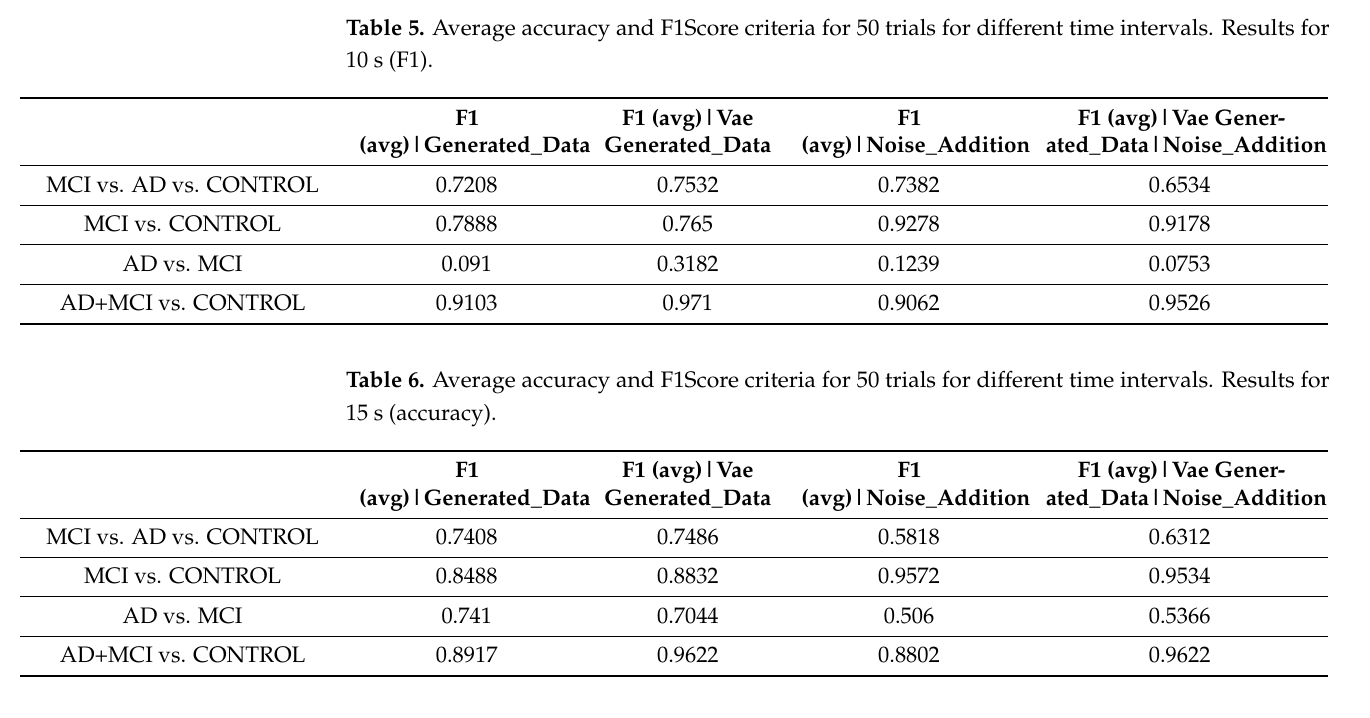
Table 7. Average accuracy and F1Score criteria for 50 trials for different time intervals. Results for 15 s